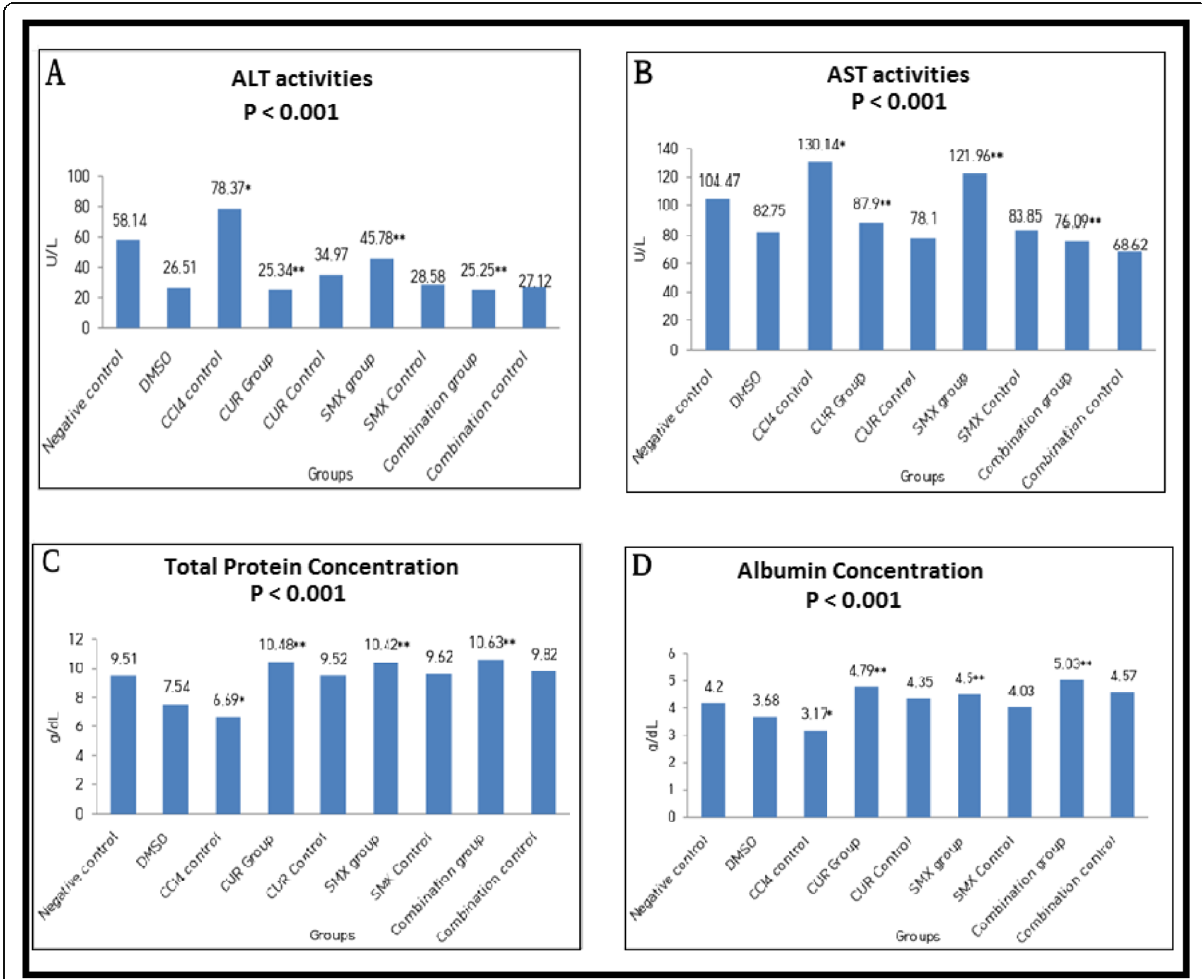
Fig. 7 Biochemical markers of hepatic injury (liver function tests). a ALT activities, b AST activities, c total protein concentrations, and d albumin concentrations. Results were expressed as mean (*) compared with normal control, (**) compared with CCl 4 control, and showed a highly significant difference from control value at ( p <